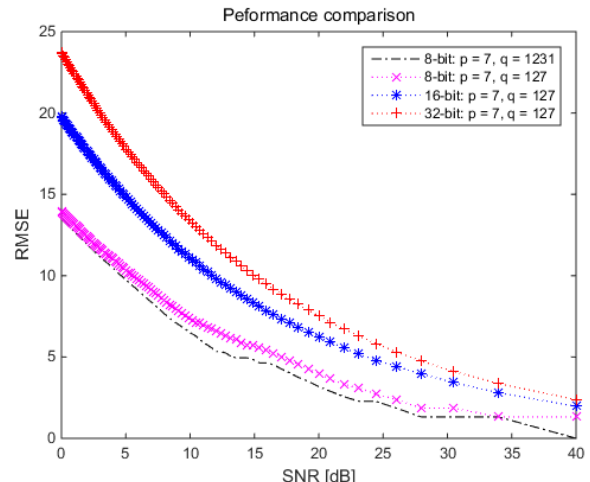
Figure 10. RMSE performance comparison with 8-, 16-, and 32-bit data lengths under prime numbers 𝑝 = 7 and 𝑞 = 127 or 1231.